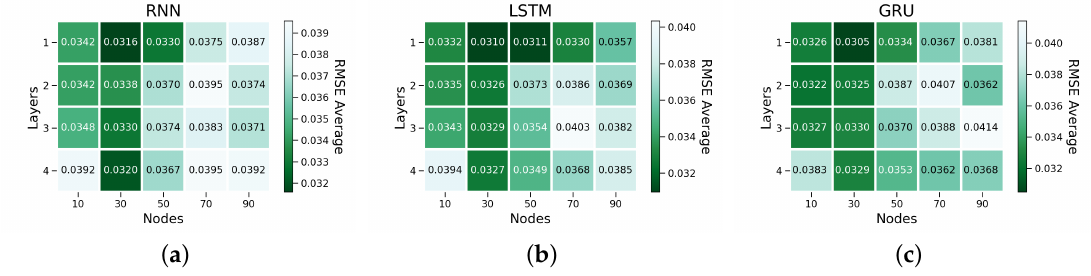
Figure 3. Root mean squared error (RMSE) grid search result for ( a ) simple RNN, ( b ) LSTM, and ( c ) GRU.